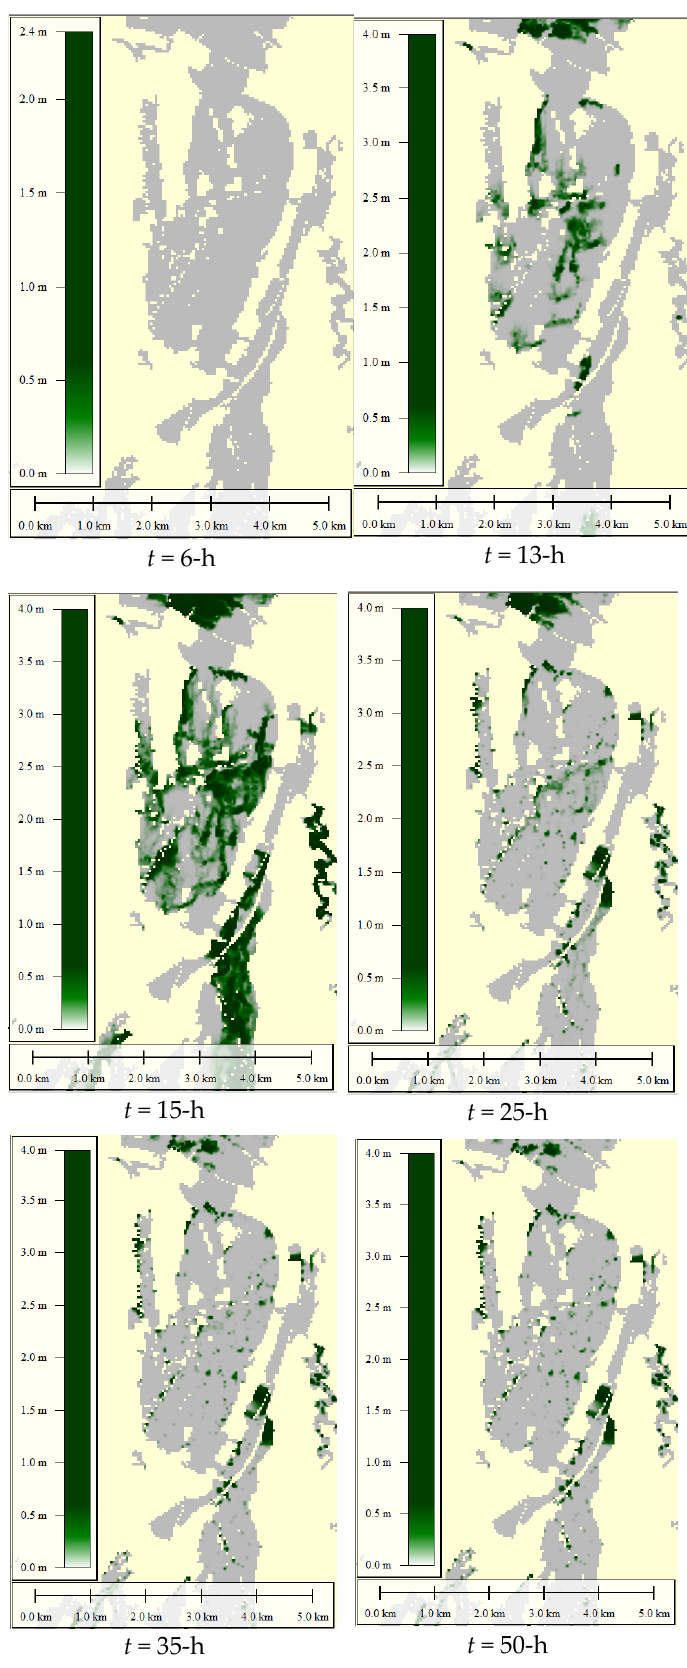
Figure 17. Resulting flood map from the SOBEK model in study area Miaoli City.